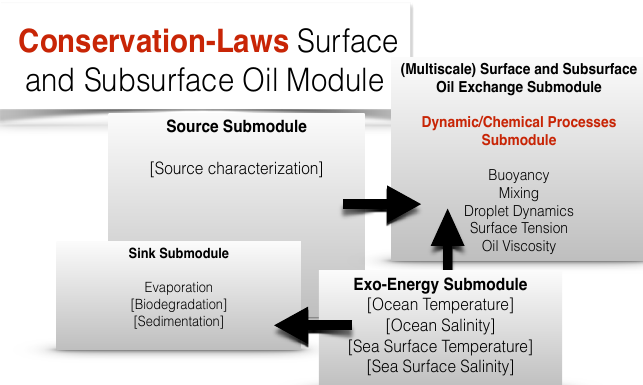
Figure 2. Mass and Energy Conservation Module used to evolve the dynamics of surface and subsurface oil and their exchanges. The multiscale exchange module distinguishes this model from other oil transport models. See Figures 1 and 3.